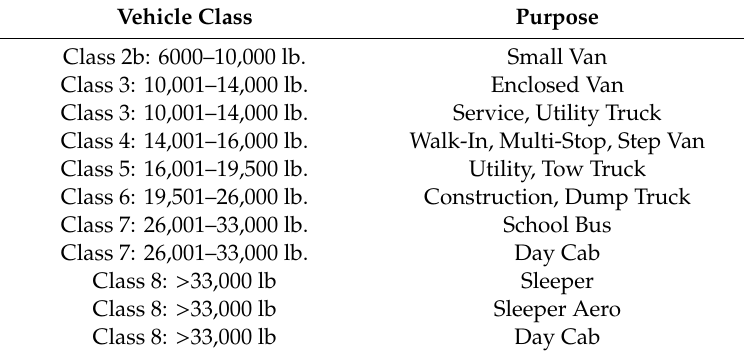
Table 1. Vehicles chosen to represent the medium- and heavy-duty market in the US. Vehicle Class